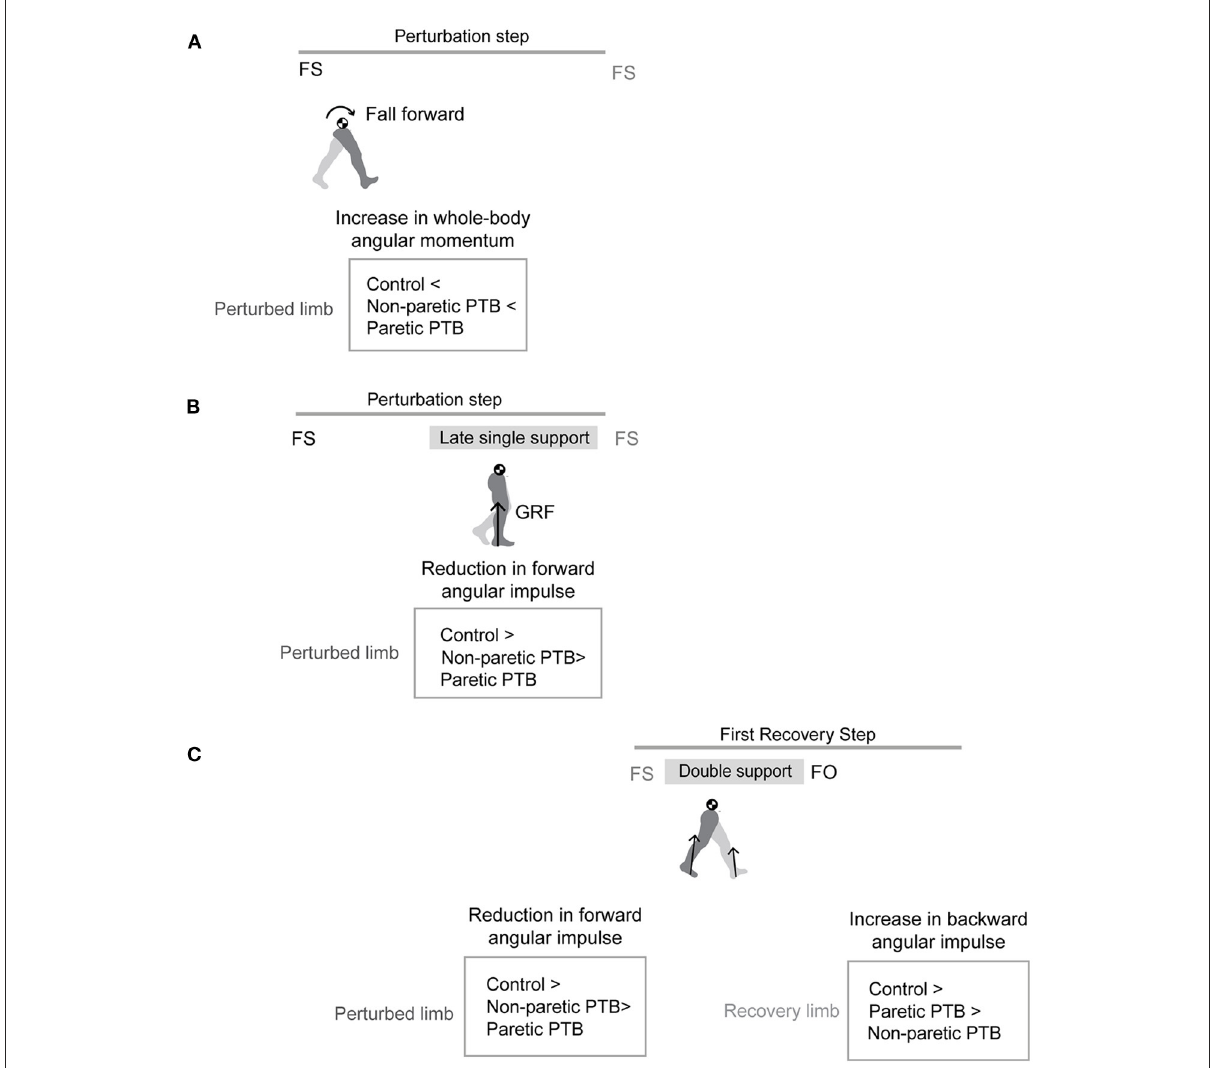
FIGURE1 Graphical illustration of hypothesized differences in whole-body angular momentum and angular impulses. (A) Hypothesis for changes in whole-body angular momentum during the perturbation step relative to that measured during the pre-perturbation step. (B) Hypothesis for changes in angular impulse during the late single support phase of the perturbation step relative to that measured during the pre-perturbation step. (C) Hypothesis for changes in the trailing perturbed limb angular impulse and the leading limb angular impulse during the double support phase of the first recovery step relative to that measured during the pre-perturbation step (FS, foot strike; FO, foot-off; GRF, ground reaction force; PTB,